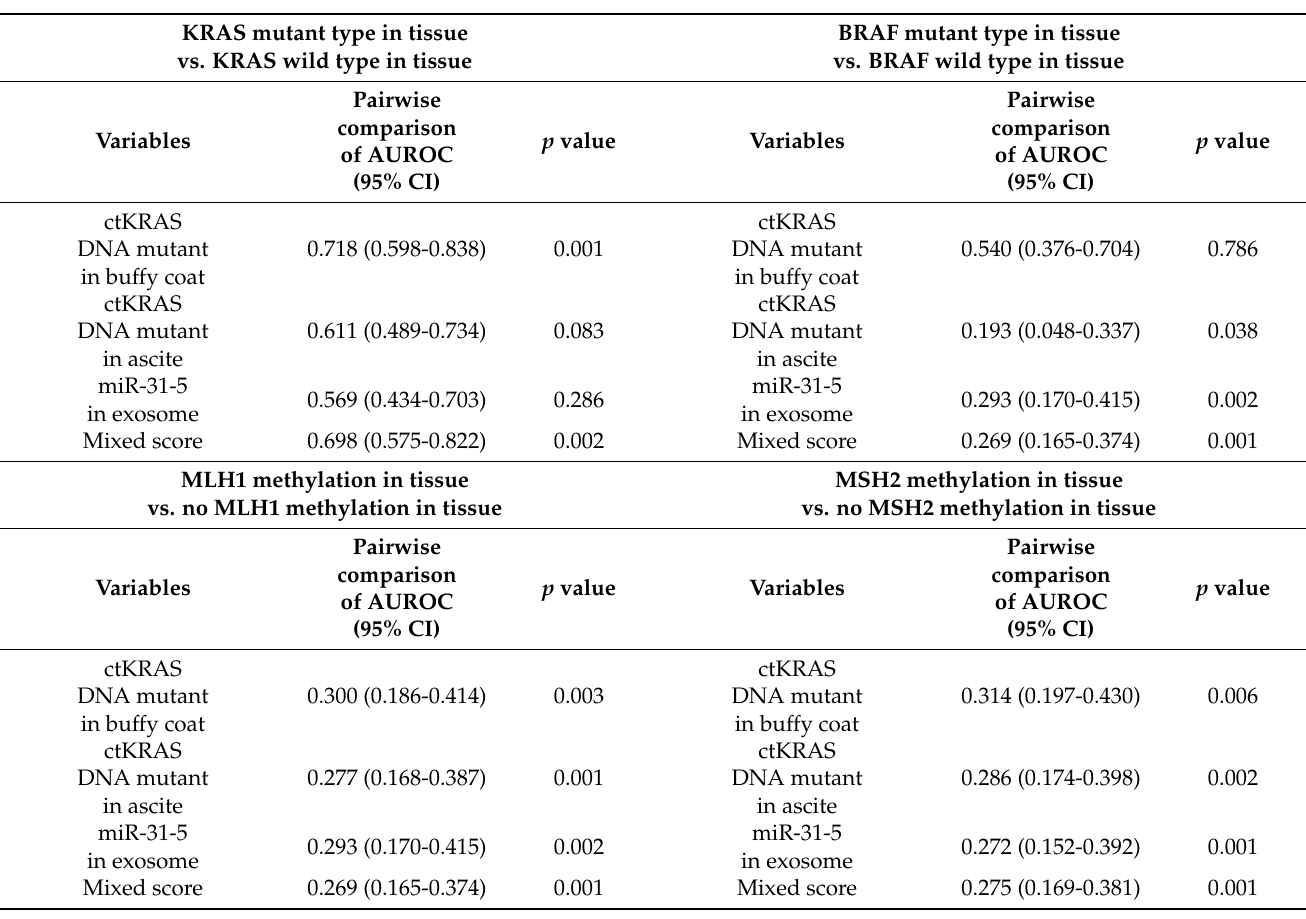
Table 1. Diagnostic capability of ctKRAS G12D and miR-31-5 analysis compared to KRAS, BRAF, MLH1, and MSH2 in